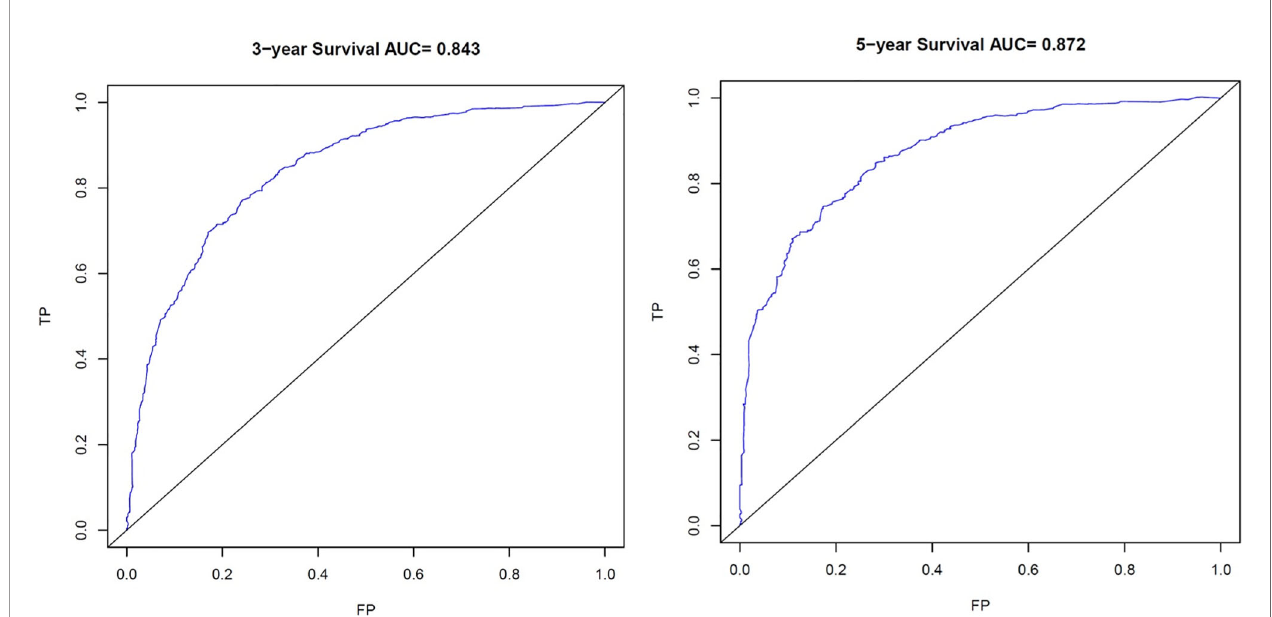
FIGURE 5 | Receiver Operating Characteristic (ROC) curves. ROC of 3- and 5-year Overall Survival (OS) for signet ring cell carcinoma (SRC) patients. TP, True Positives; FP, False Positives; AUC, area under the ROC